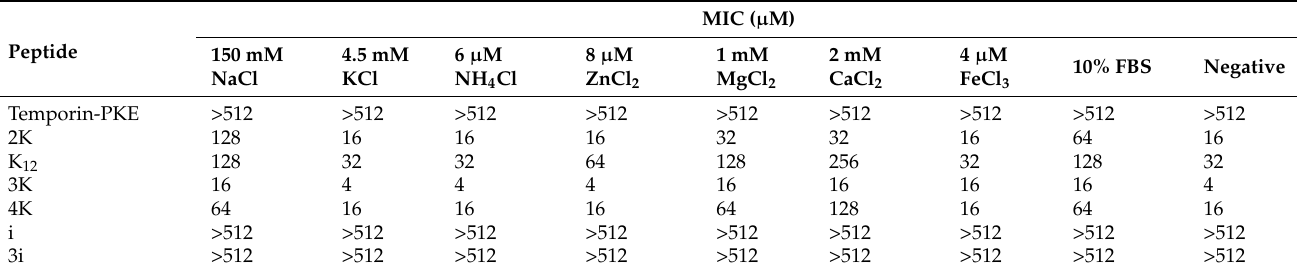
Table 8. The MICs of temporin-PKE and its analogues against K. pneumoniae in the presence of various salts and 10% FBS.